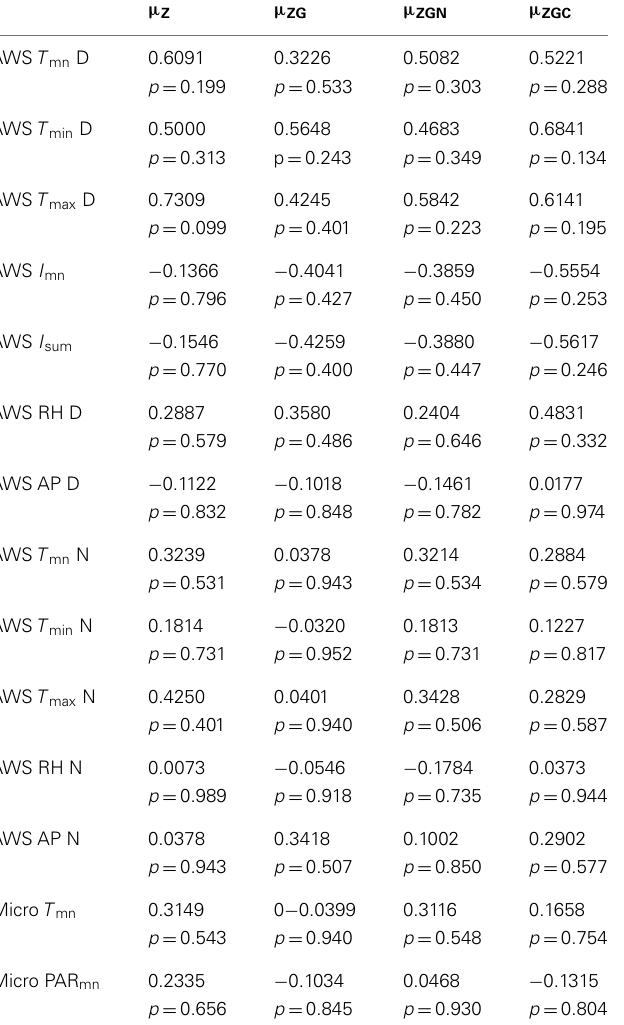
Table 6 | Correlations between environmental conditions measured by AWS and/or in the out-door unit, and µ part of control and nutrient manipulated treatments in the out-door experiment.